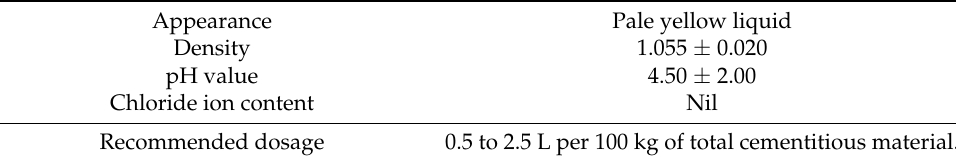
Table 2. Properties of the high-range water-reducer CHRYSO Delta CQ